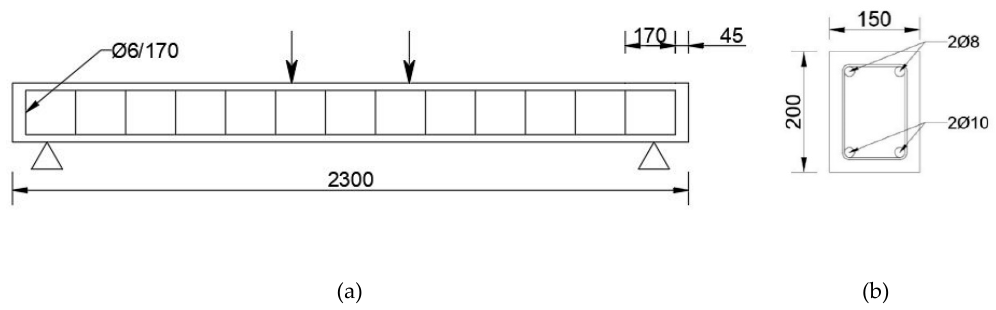
Figure 2. Geometry of simulated corroded reinforced concrete (RC) beams investigated by Rodriguez et al. [30] in mm. ( a ) longitudinal section; ( b ) cross-section.